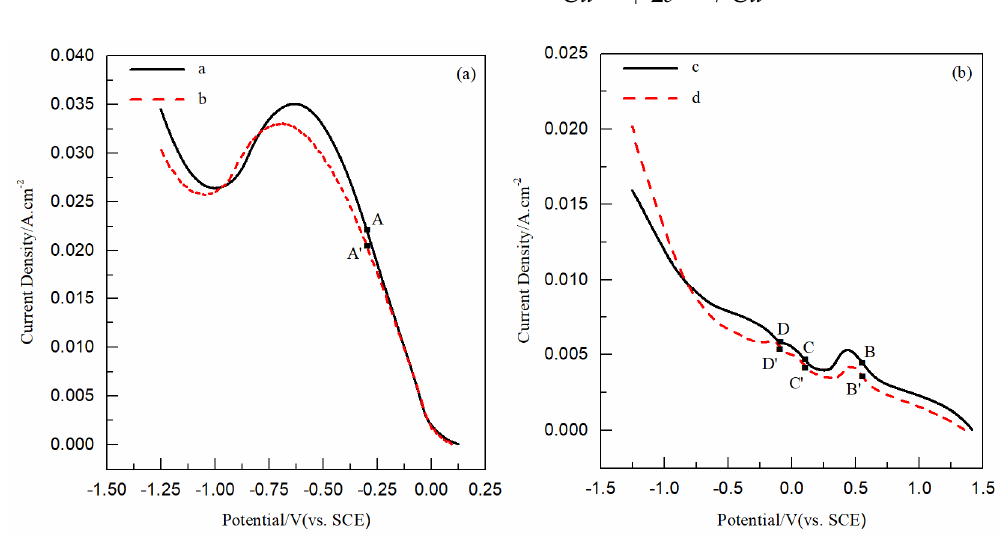
Figure 1. LSV curves obtained in Cu(II)/Se(IV) unitary solutions: ( a ) curve a in solution 1 without PEG, curve b in solution 2 with 4 μ M PEG; and ( b ) curve c in solution 3 without PEG, curve d in solution 4 with 4 μ M PEG. Scan rate: 200 mV/s.